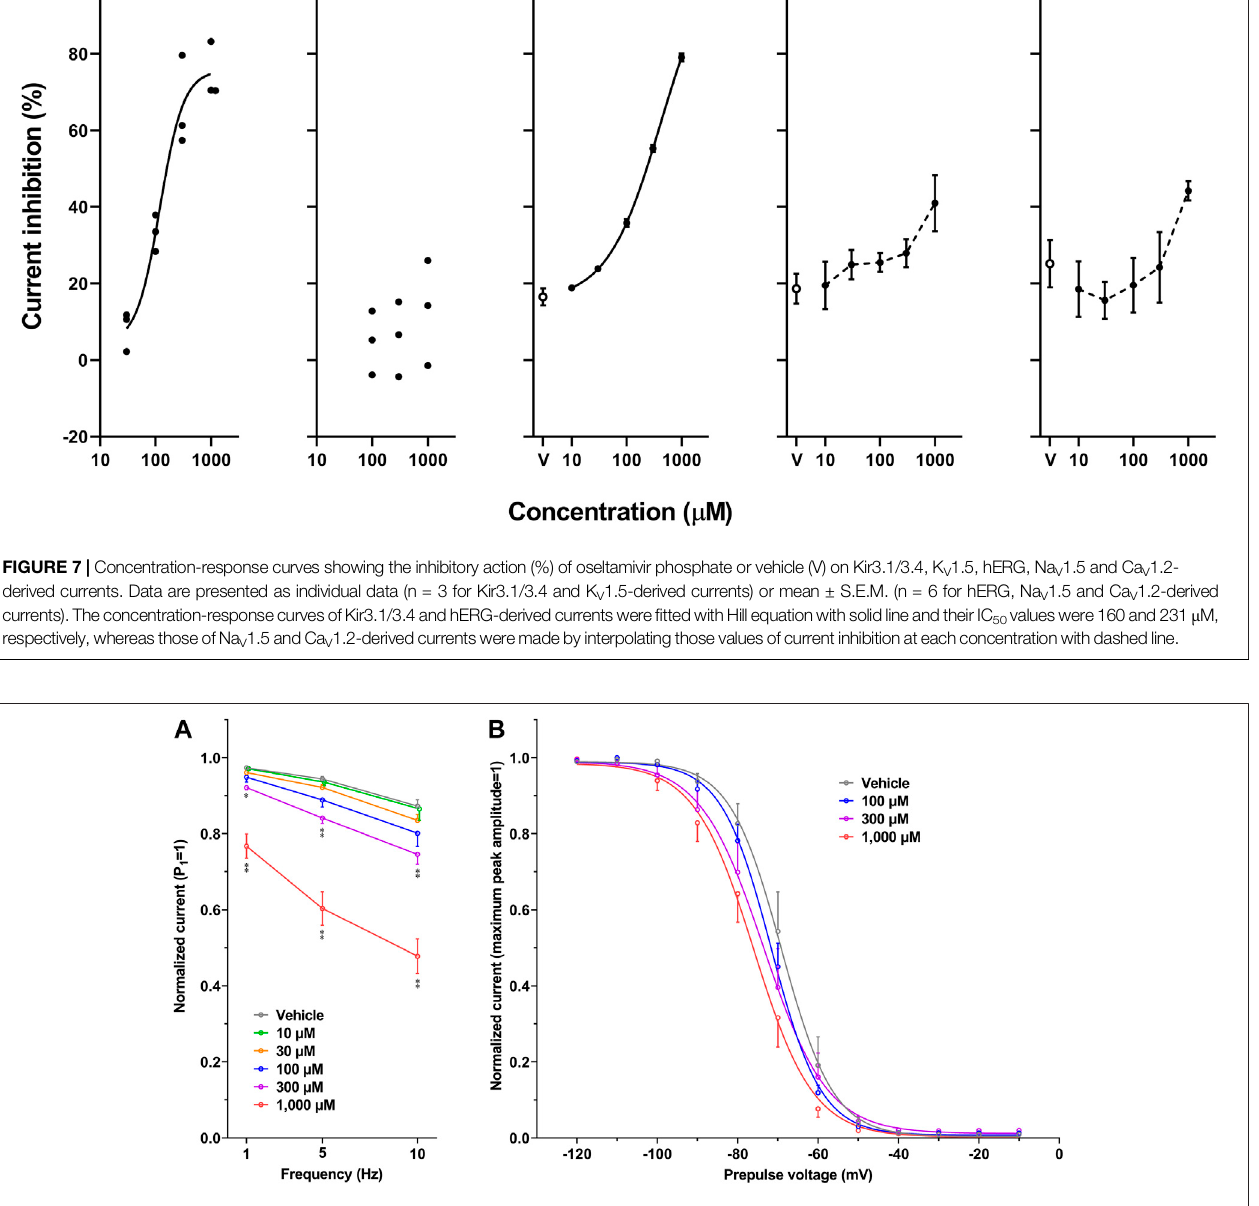
FIGURE8| Frequency-andVoltage-dependentblockofNa V 1.5byoseltamivir. (A) ThenormalizedpeakamplitudesofNa V 1.5-derivedcurrentat30thtestpulsein the presence of vehicle (n (cid:1) 5) and oseltamivir (n (cid:1) 6 for each concentration) were compared at the pulse frequencies of 1, 5 and 10 Hz. The peak amplitude was normalizedbythatat1ststeppulse(P1 (cid:1) 1).ThereductionofNa V 1.5currentbyoseltamivirwasaugmentedinafrequency-dependentmanner.* p < 0.05and** p < 0.01 vs. vehicle at the same frequency. (B) The steady-state inactivation curves of Na V 1.5 channels in the presence of vehicle (n (cid:1) 6) and oseltamivir (n (cid:1) 6 for each concentration). The peak amplitude was normalized by the maximum peak amplitude (maximum peak amplitude (cid:1) 1). Oseltamivir negatively shifted the curves in a concentration-related manner. Data are presented as mean ± S.E.M.